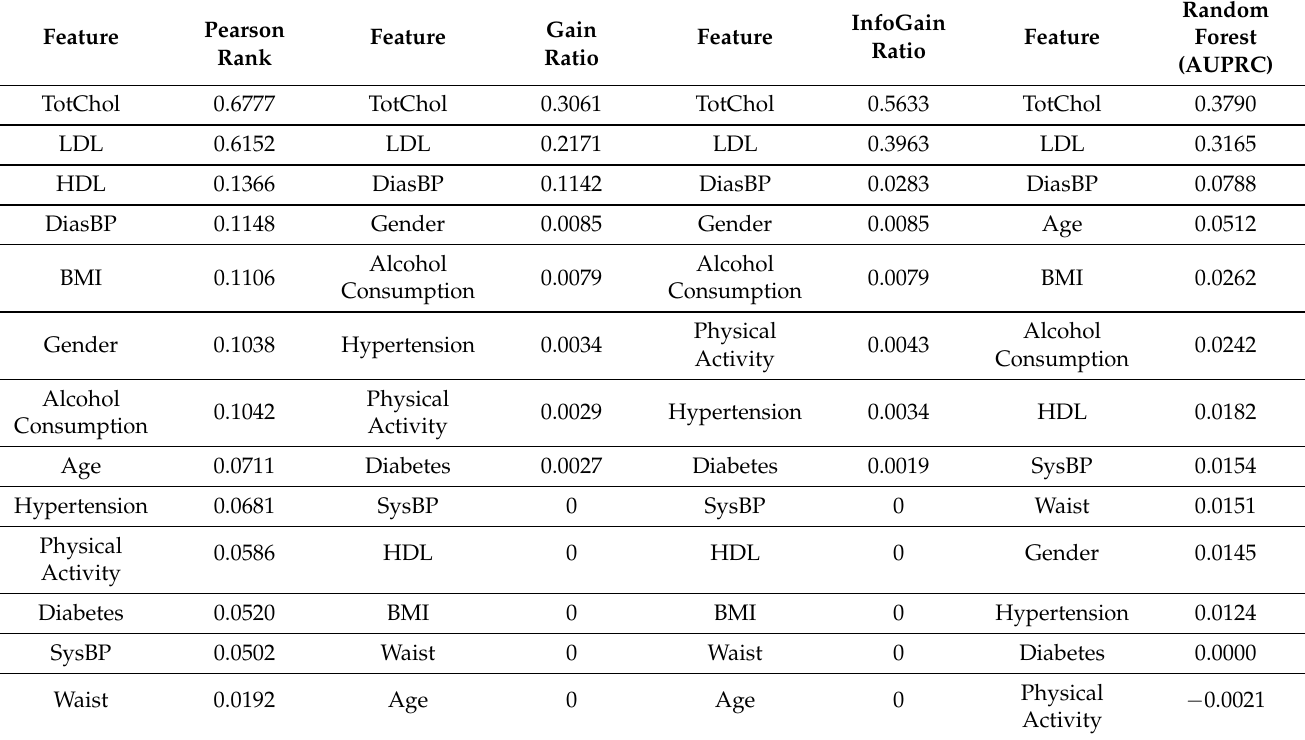
Table 2. Features’ order of importance in the balanced data.